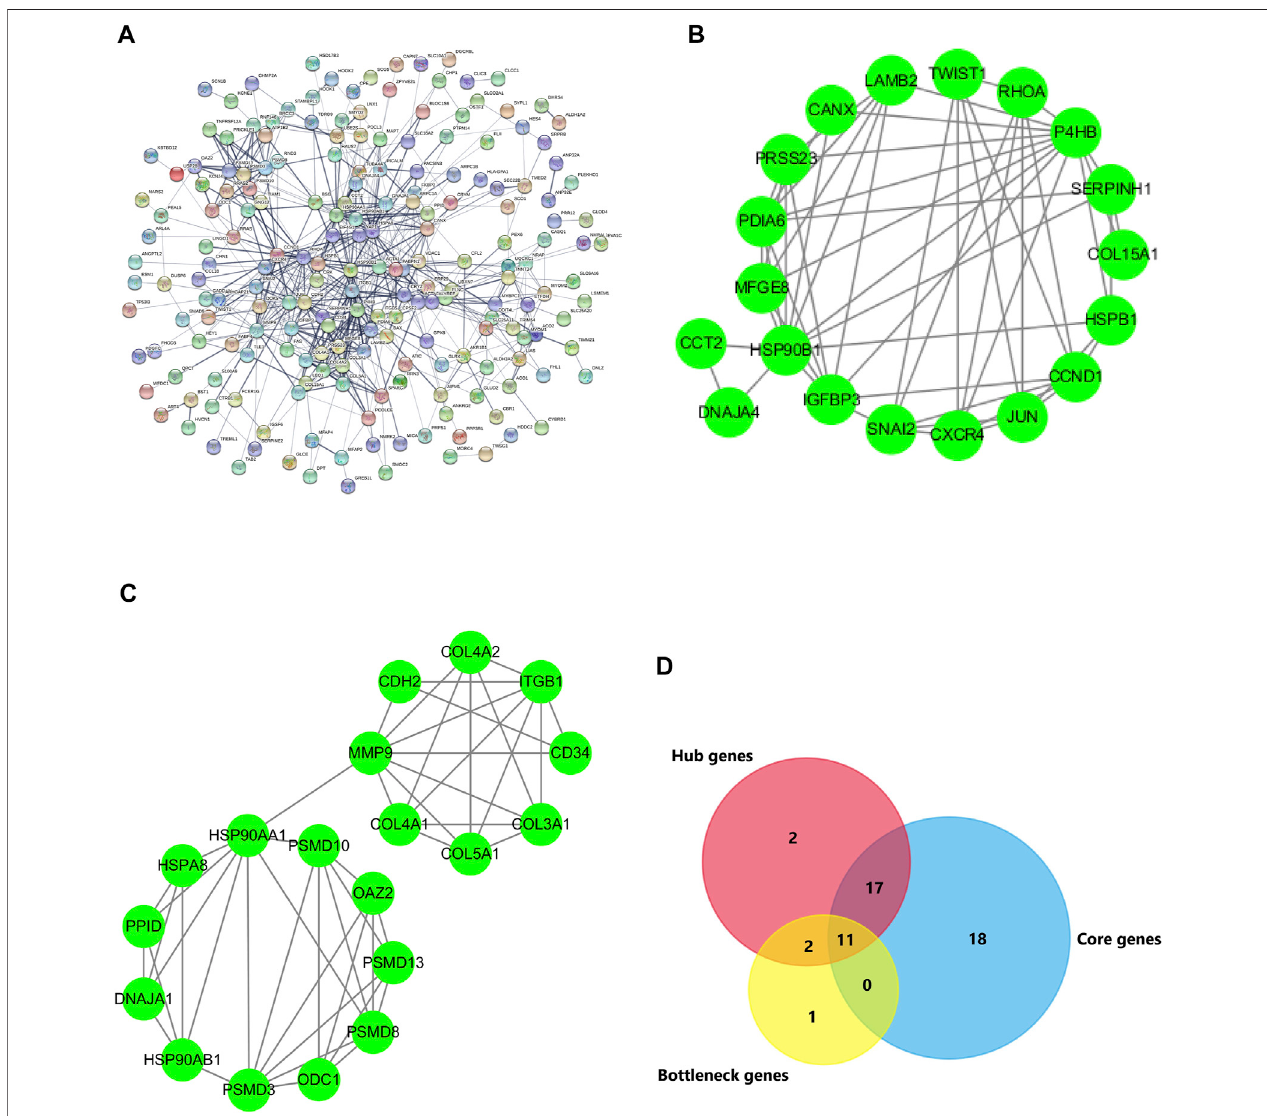
FIGURE 5 | PPI network of DEGs and key genes. (A) DEGs with 201 nodes and 590 edges displayed using STRING 11.0. (B,C) The PPI network data from STRING was further analyzed using Cytoscape. The 32 hub genes and 14 bottleneck genes were screened using Cytoscape software plug-in Centiscape and 46 core genes were screened using MCODE plug-in. (D) The key genes are obtained by the intersection of hub genes, bottleneck genes, and core genes using